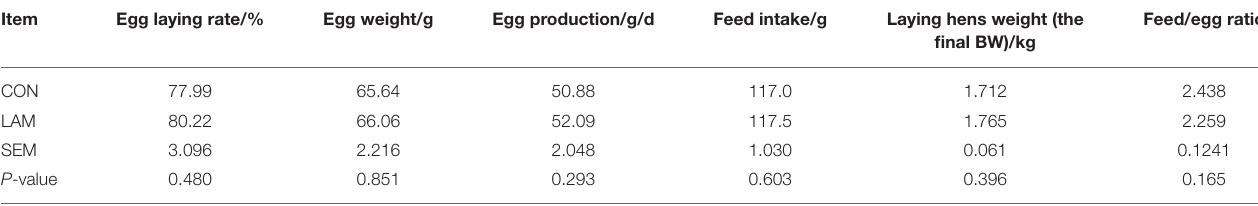
TABLE 1 | The effect of lipoamide (LAM) on the reproduction performance of old laying hens at 108–123 weeks. Item Egg laying rate/%